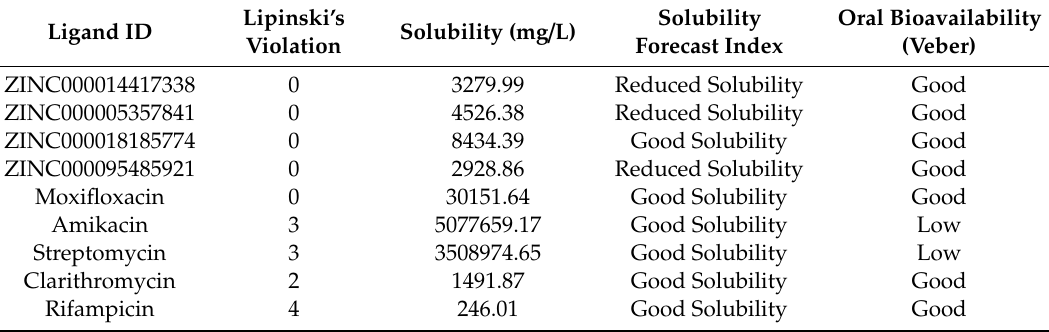
Table 7. Pharmacological profiles of the lead compounds and five known drugs for Buruli ulcer. The known drugs are Rifampicin, Streptomycin, Clarithromycin, Moxifloxacin, and